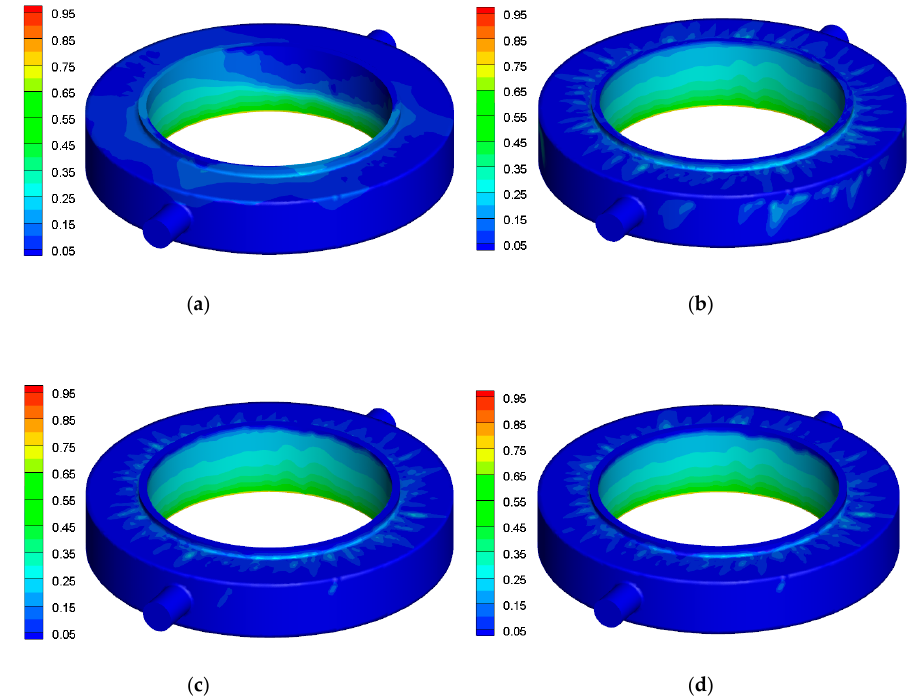
Figure 7. Oil droplet volume fraction (%) at di ff erent time with diameter in the range of 28 to 40 µ m when the air inflow is 12 g / s, oil inflow is 15 g / s, and initial oil droplet diameter is 28 µ m (the oil inlet is on the bottom, the vent is in front and the z axial direction is up). ( a ) t = 50 ms; ( b ) t = 100 ms; ( c ) t = 200 ms; ( d ) t = 400